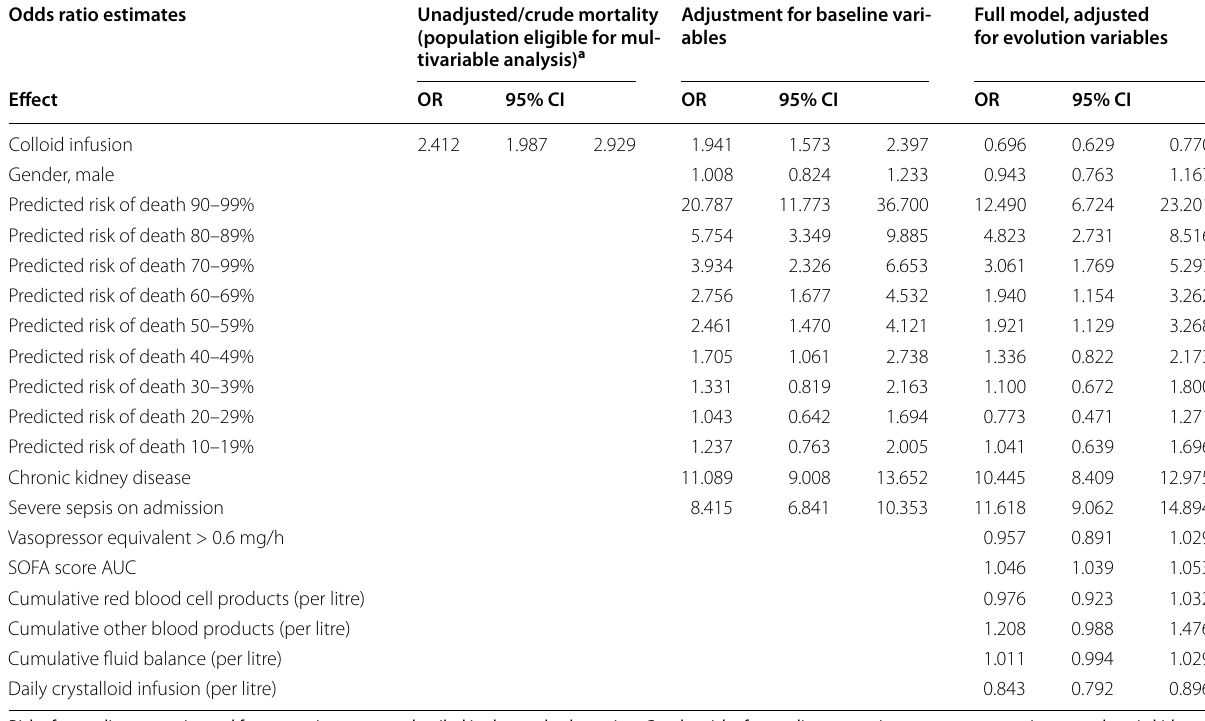
Table 3 Effects of colloid infusion in logistic regression analysis of RIFLE